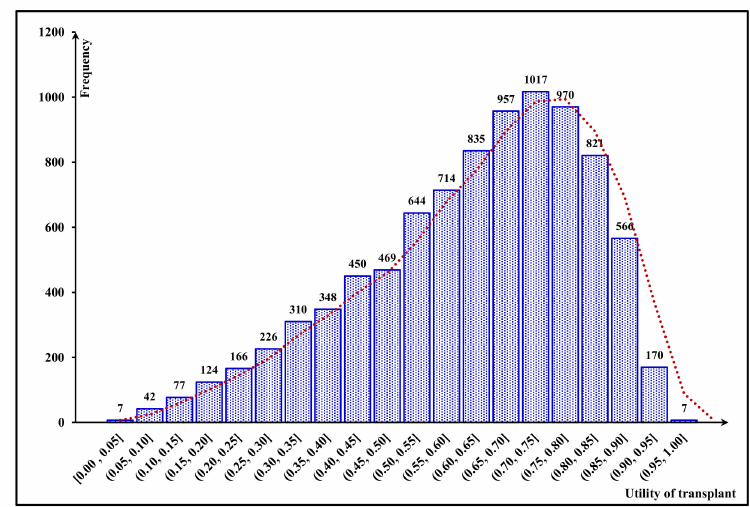
Figure 6. Frequency distribution of utility values.